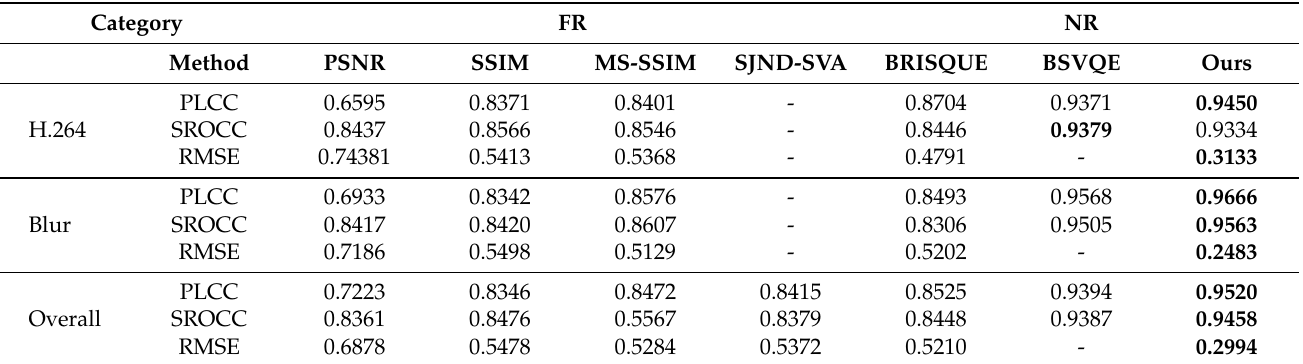
Table 1. Performance comparison of various methods on the QI-SVQA database. The best results are in bold.